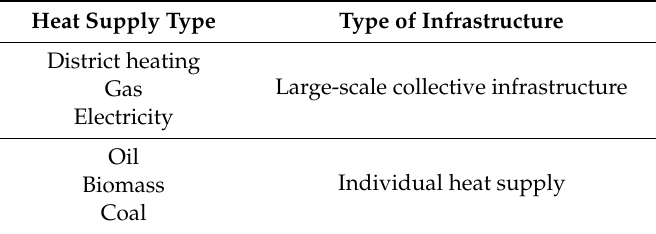
Table 1. Heat distribution infrastructure